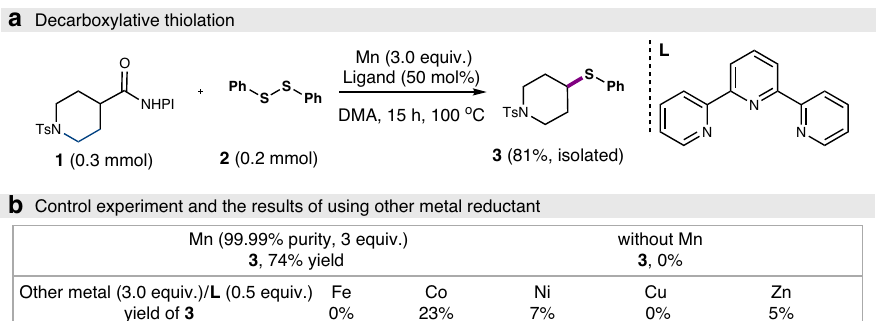
Fig. 2 Model reaction of decarboxylative thiolation. a Decarboxylative thiolation of NHPI ester. b Control experiments and the results of using other